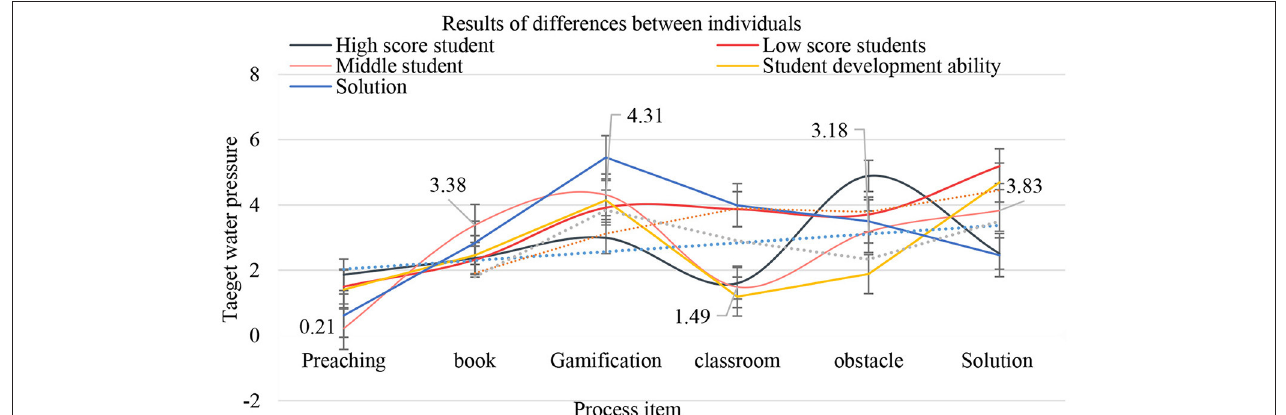
FIGURE 4 | Results of differences between individuals.